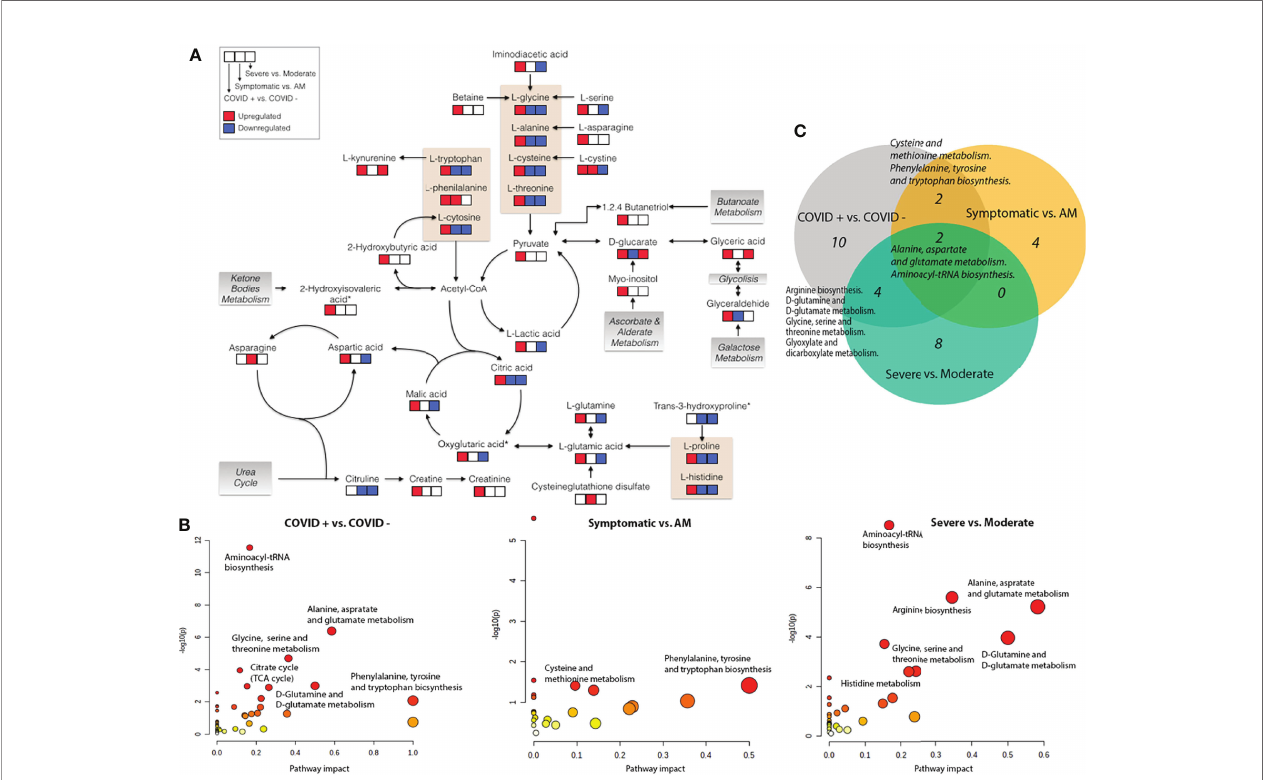
FIGURE 4 | Metabolic pathways. (A) Schematic overview of key distributed metabolites and their metabolic relationships. Signi fi cant up (red) and down (blue) regulation are shown for the different severity status pairwise comparisons; (B) Pathway analysis based on enrichment analysis procedure. The most relevant metabolic pathways are represented according to their impact and adjusted p -value (obtained using MetaboAnalyst software v 4.0); (C) Venn diagram showing common signi fi cant metabolic pathways between different pairwise severity status comparisons. Oxoglutaric acid*, Alpha-ketoglutaric acid. 2-Hydroxyisovaleric acid*, 2-Hydroxy-3-methylbutyric acid/Pentanoic acid 2-[(trimethylsilyl)oxy]-, trimethylsilyl ester. Trans-3-hydroxyproline*, trans-3-hydroxyproline/trans-4-